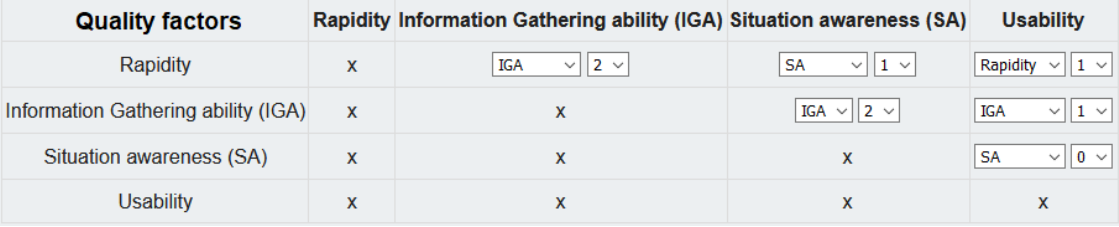
Figure 8. Cross weighting technique with a cross-table—quality factors pair